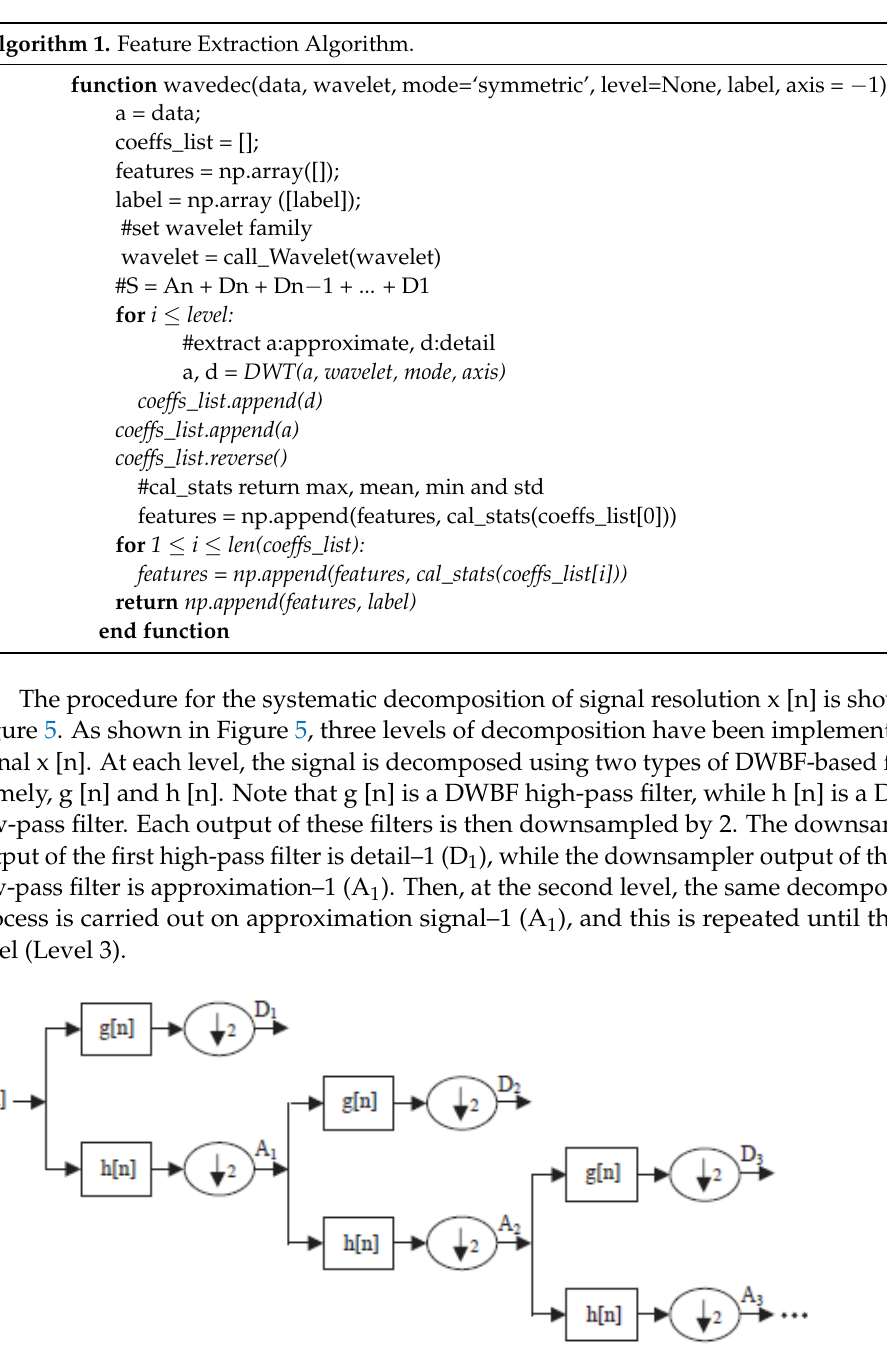
Figure 5. DWT sub-band decomposition where g [n] is a high-pass filter and h [n] is a low-pass